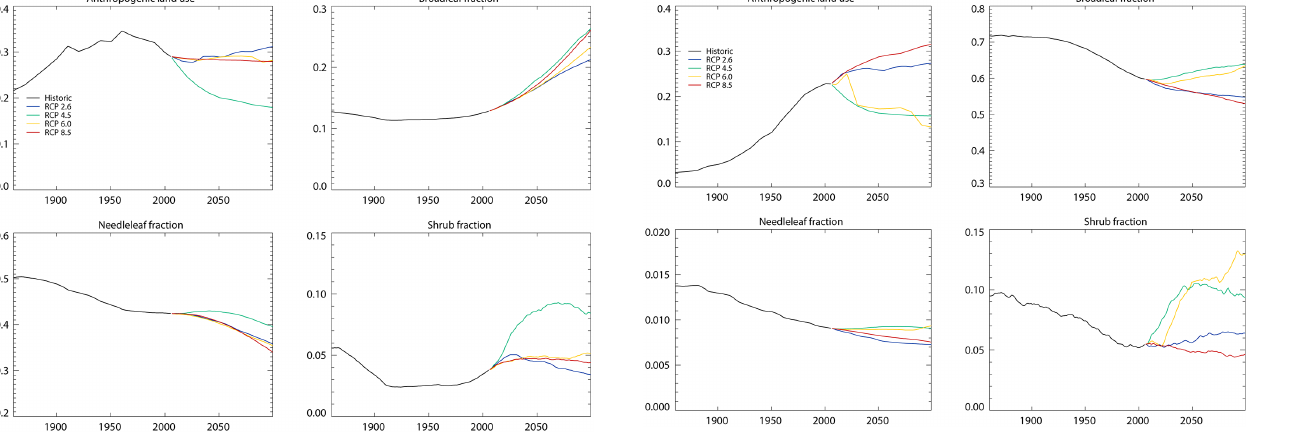
Figure 9. Fractional cover of (a) anthropogenic land use (disturbed fraction), (b) broadleaf tree, (c) needleleaf tree and (d) shrub in HadGEM2-ES in northern Europe under the 4 RCPs. Note differ- ence scales used on the y axes.